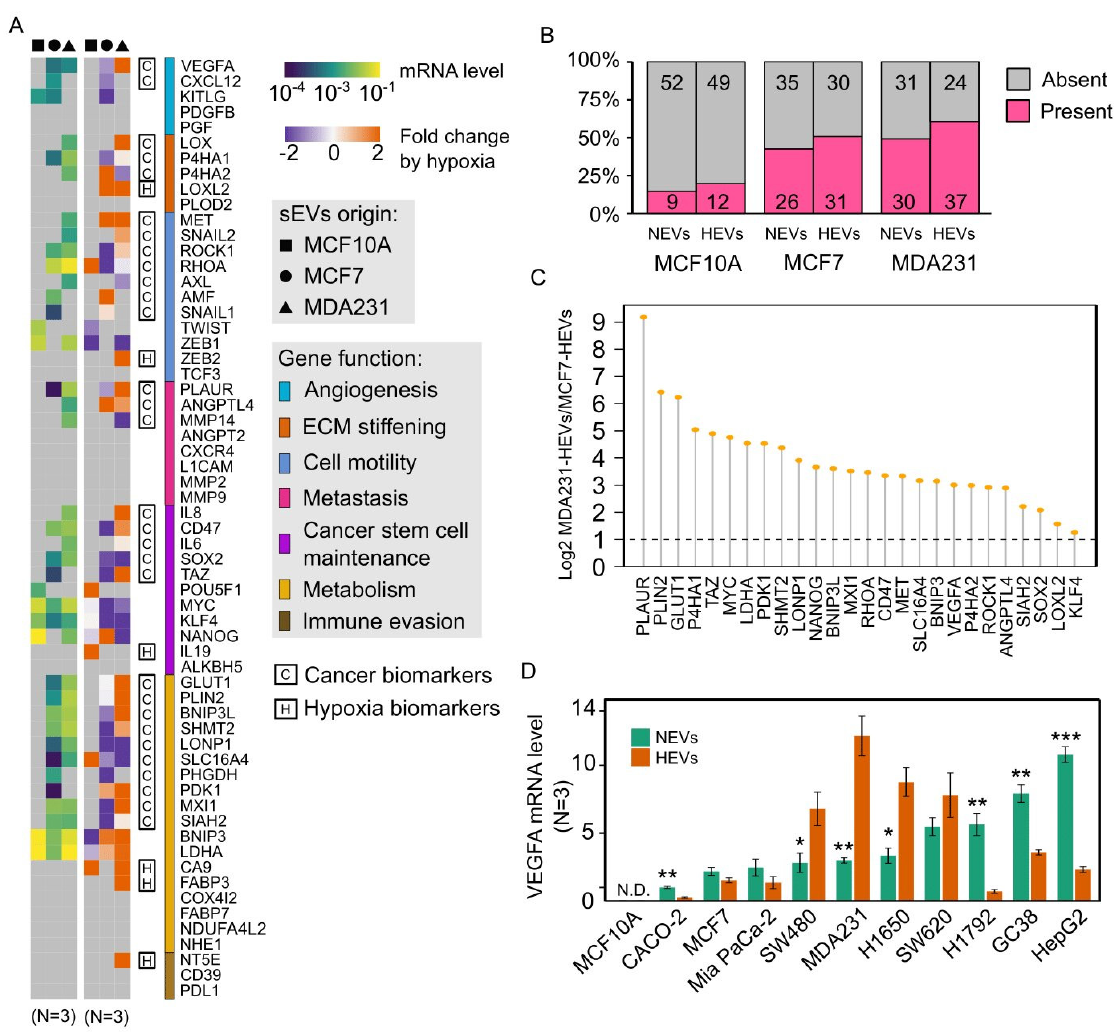
Figure 2. Quantification of EV-mRNAs of the hypoxia gene panel. ( A ) The two heatmaps show the normoxic EV-mRNA levels (left) and the hypoxia-induced log2 fold changes of EV-mRNA level (right). The expression level is averaged from three independent experiments. The 61 genes are grouped by their contributions in cancer development. Potential cancer biomarker and hypoxia biomarker genes are marked. ( B ) The proportion of the hypoxia gene panel whose transcripts were detected in the EVs. The two cancer cell lines-derived EVs harbored the mRNAs of a much larger proportion of the hypoxia gene panel. ( C ) MCF7-HEVs and MDA231-HEVs carried 26 mRNAs in common from the panel. All these genes had > 2 folds higher mRNA levels in MDA231-HEVs compared to MCF7-HEVs. ( D ) VEGFA mRNAs were present in the EVs derived from multiple cancer cell lines with varied levels. Most of the EV VEGFA mRNA levels were significantly altered by hypoxia ( N = 3). * P < 0.05, ** P < 0.01, *** P < 0.001 based on Student’s t test for ( D ).